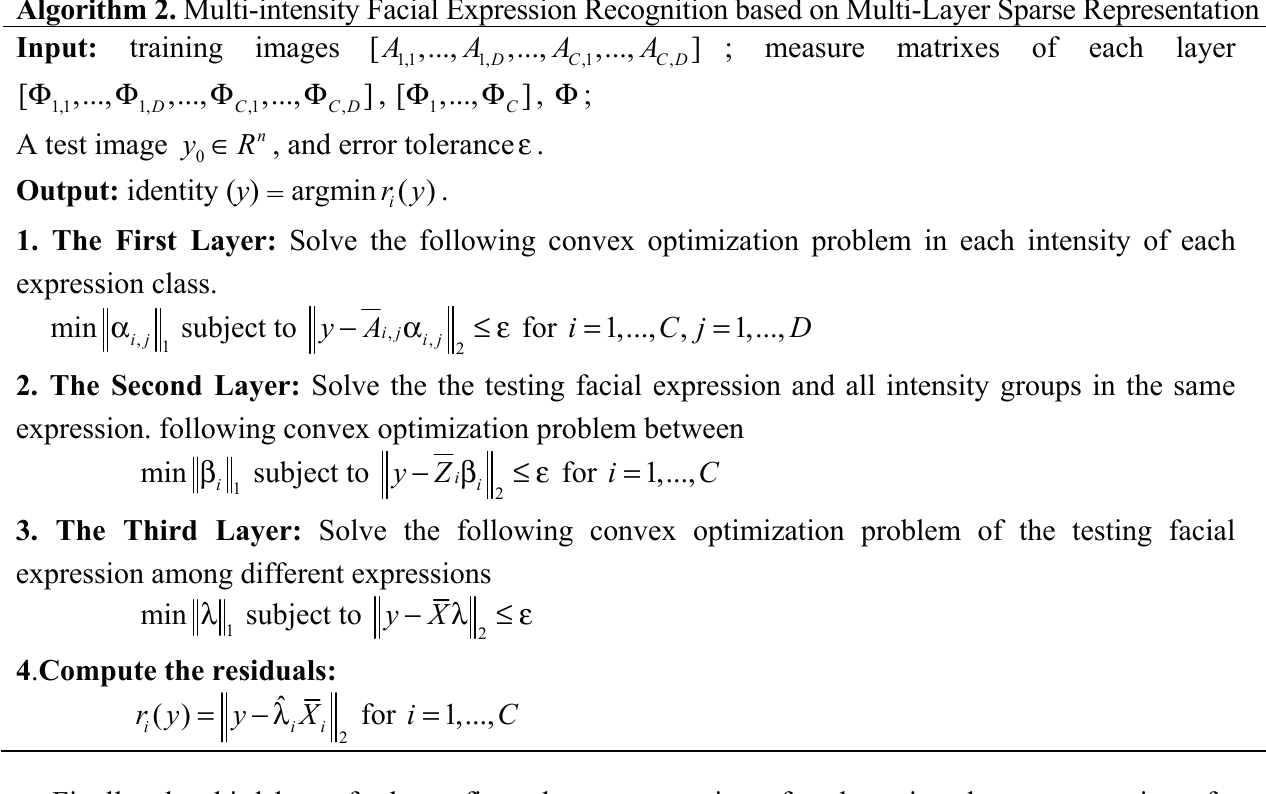
Algorithm 2. Multi-intensity Facial Expression Recognition based on Multi-Layer Sparse